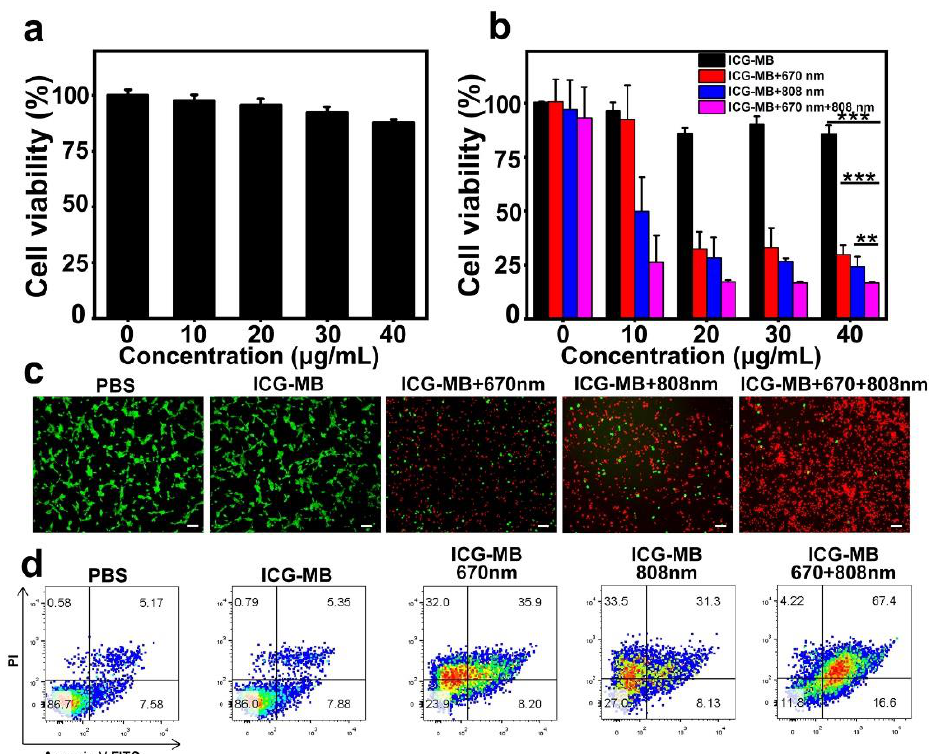
Figure 5. ( a ) In vitro cytotoxicity of ICG-MB against NCM356 cells. ( b ) In vitro cytotoxicity of ICG-MB against CT26 cells of ICG-MB, with or without 670 nm or 808 nm laser irradiation (** p < 0.01, and *** p < 0.001). ( c ) Fluorescence images of calcein AM (green, live cells) and propidium iodide (red, dead cells) co-stained CT26 cells of ICG-MB with or without 670 nm or 808 nm laser irradiation. Scale bar: 50 µ m. ( d ) Quantitative apoptosis analysis of CT26 cells treated by ICG-MB with or without 670 nm or 808 nm laser